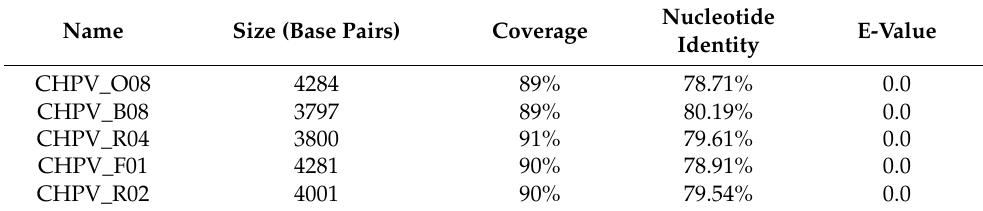
Table 1. Nucleotide identity of CHPV sequences identified in M. molossus